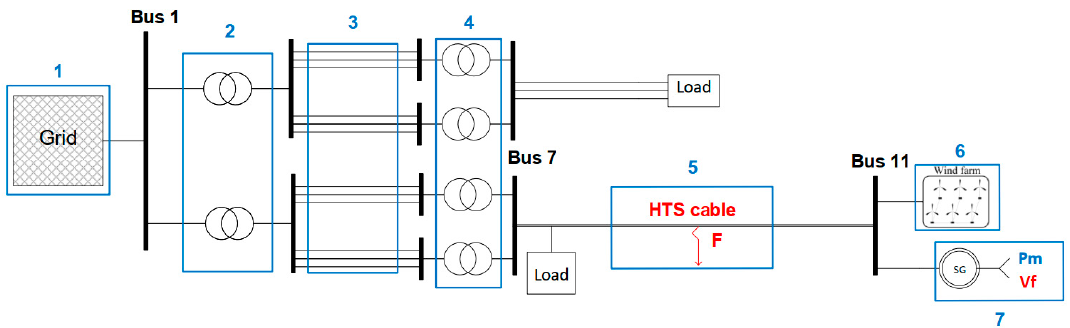
Figure 5. Flowchart corresponding to the calculation process for the resistance values of the HTS tapes 𝑅 (cid:3009)(cid:3021)(cid:3020) , the copper stabilizer 𝑅 (cid:3004)(cid:3048) , the equivalent 𝑅 (cid:3032)(cid:3044) , and the variation of the temperature 𝛥𝛵 of the superconductor.